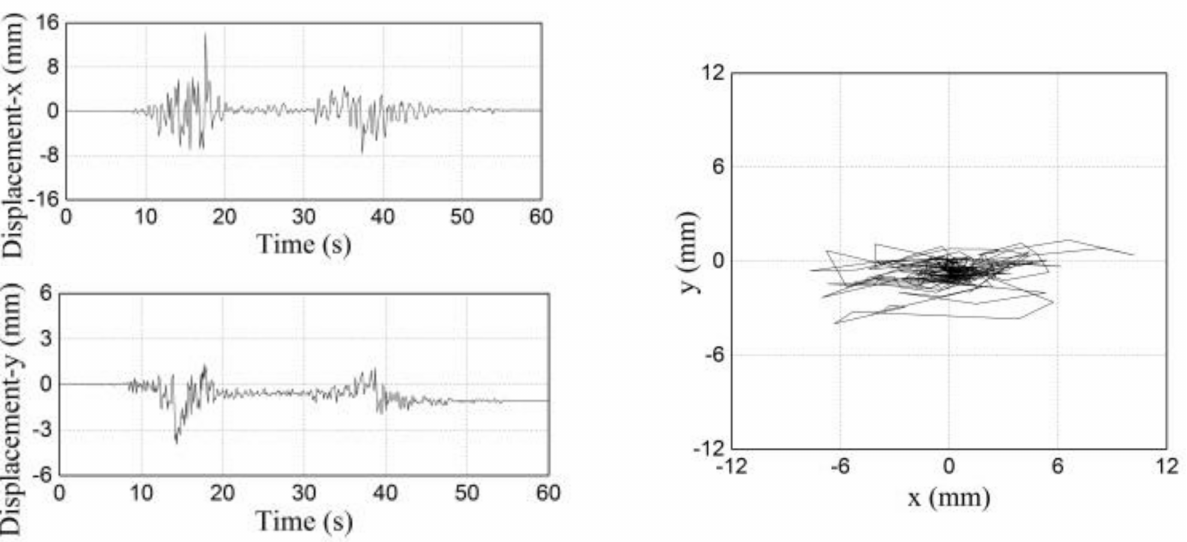
Figure 29. The relative displacements and movement locus of the b200d380 bearing subjected to Wo-long (high-frequency) ground motion when PGA = 2 m/s 2 .